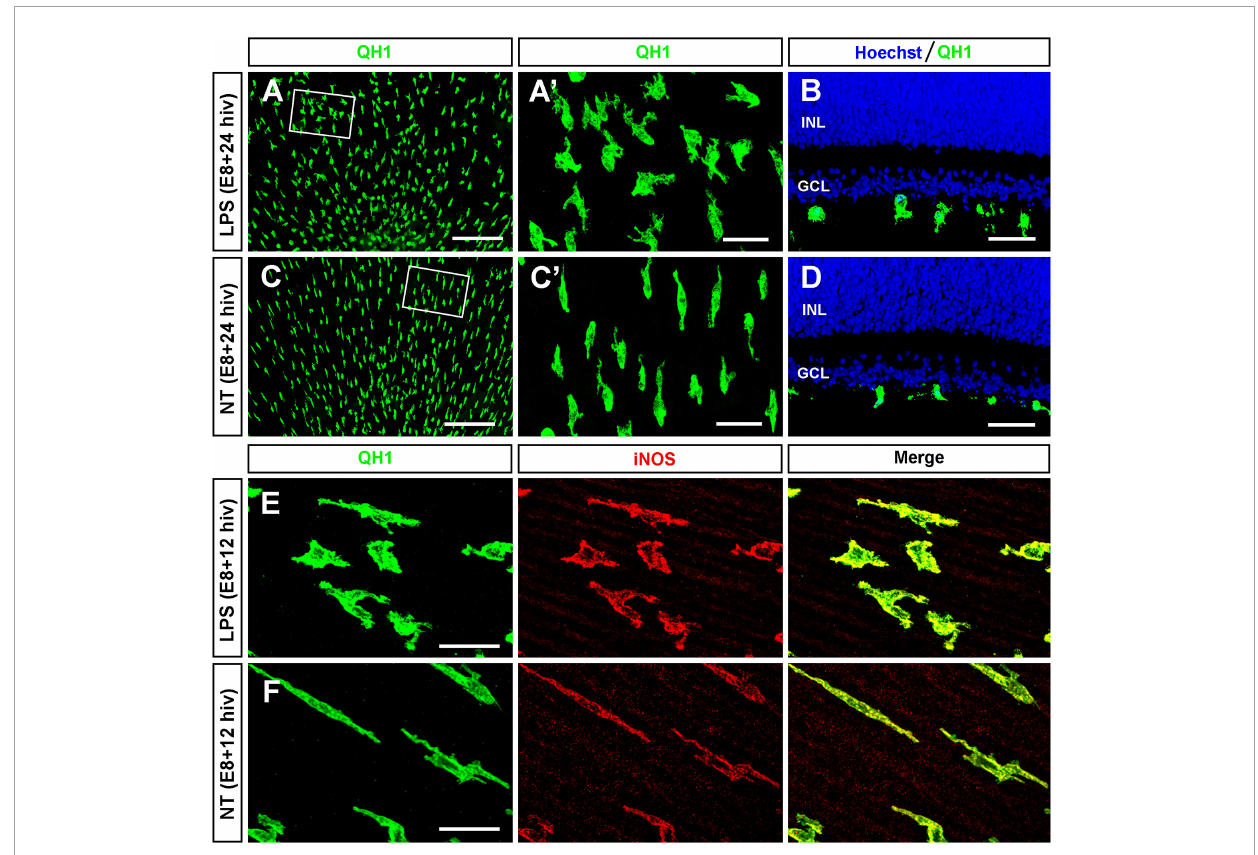
FIGURE1 LPS-treatment of E8 retina explants induces changes in morphology and iNOS expression in immature microglia. (A–D) Representative images of QH1-immunolabeled microglia (green) in whole-mounts (A,C) and cross cryosections (B,D) of LPS-treated [LPS; (A,B) ] and non-treated [NT; (C,D) ] retina explants from E8 quail embryos cultured for 24 h (E8 + 24 hiv). Hoechst nuclear staining (blue) was used to visualize the retinal layers in cryosections (INL: inner nuclear layer; GCL: ganglion cell layer). The boxed areas in panels (A,C) are shown at a higher magnification in panels (A’,C’) , respectively. Note morphological changes of microglial cells in LPS-treated explants (A,A’,B) compared with those in the non-treated explants (C,C’,D) . (E,F) Representative confocal images of QH1 (green) and anti-iNOS (red) double immunostained microglial cells in LPS-treated [LPS; (E) ] and non-treated [NT; (F) ] E8 + 12 hiv retina explants. Green, red, and merged channels are shown in the left (QH1), medium (iNOS), and right (Merge) panels, respectively. In addition to that, morphological changes similar to those found in E8 + 24 hiv retina explants, the iNOS labeling of microglia is higher in LPS-treated versus non-treated explants. Scale bars: 200 µ m in panels (A,C) ; 40 µ m in panels (A’,B,C’,D) ; 25 µ m in panels (E,F)